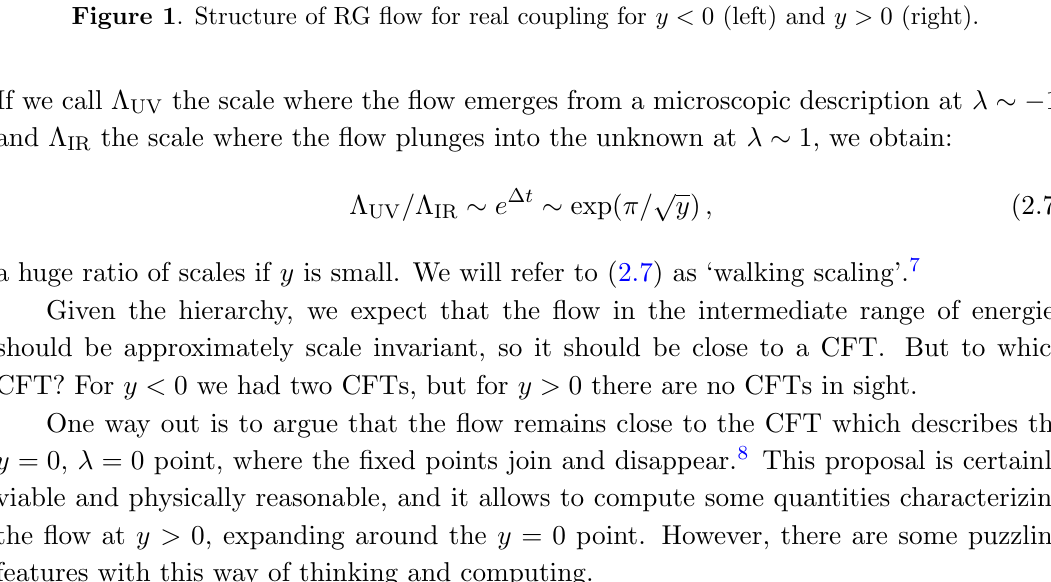
Figure 1 . Structure of RG (cid:13)ow for real coupling for y < 0 (left) and y > 0